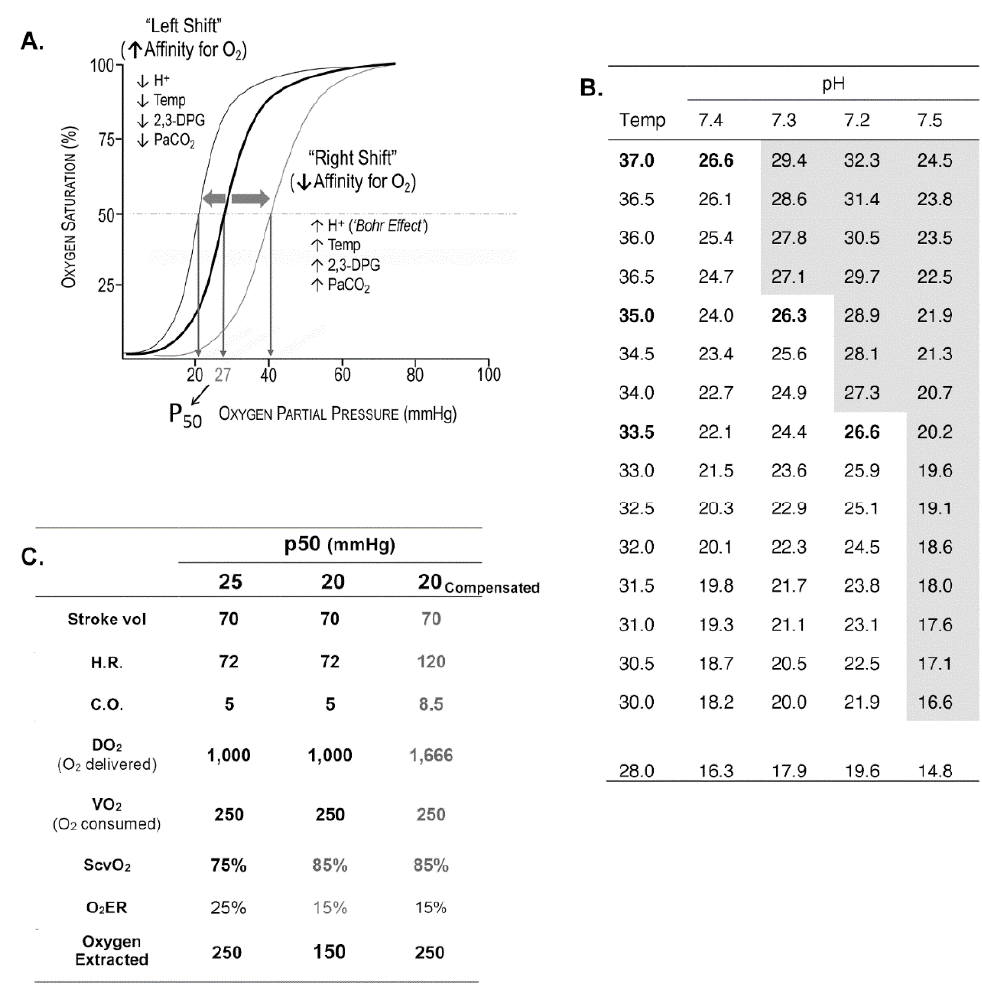
Figure 1. ( A ) OHD curve which relates the saturation of Hgb ( y -axis) to the degree of partial pressure of oxygen to which Hgb is exposed ( x -axis). The pO 2 that saturates ½ of Hgb is referred to as p50, which in this example p50 = 27 mmHg. The p50 is the conventional measure of affinity of Hgb for oxygen. The lower the p50 the higher the affinity of Hgb for oxygen. The ‘steep’ portion of the oxyHgb dissociation curve is in the range of pO 2 that exists in systemic capillaries (thus a small decrease in systemic capillary pO 2 can result in the release of large amounts of oxygen for diffusion to, and uptake by cells). As shown in the figure, several factors increase the affinity of Hgb for oxygen (leftward shift; ↓ p50) or decrease affinity (rightward shift; ↑ p50). Biochemically, H+ is a heterotropic allosteric inhibitor of Hgb, whereas O 2 is a homeotropic allosteric activator of Hgb. ( B ) Hypothermia and acidosis have opposing effects on p50. Lower temperature shifts the curve to the left increasing Hgb affinity for oxygen and decreasing offloading in capillaries; low pH (increase in H+) decreases the affinity of Hgb for oxygen (Bohr effect) increasing oxygen availability to reverse anaerobic metabolism. A trauma patient may be, and often is hypothermic and acidotic (and coagulopathic). Whether there is a significant change in p50 can be calculated using the Hill–Langmuir equation. ( C ): Hypothetical oxygen transport variables of a normal subject (Temp = 37 °C; p50 = 25 mmHg) and a subject with hypothermia (Temp = 31 °C; p50 = 20 mmHg), before and after compensation. The p50 at 31 °C and pH = 7.4 is calculated using the Hill–Langmuir equation. A venous blood gas is obtained through a Swan Catheter introducer (7.5Fr) with the tip in the superior vena cava reveals in the hypothermic subject, central venous oxygen saturation (ScvO 2 ) = 85%. This reflects the fact that hypothermia increases the affinity of Hgb for oxygen, shifting the Hgb dissociation curve to the left. A ScvO 2 of 85% would imply only 15% of the delivered 1000 mL of oxygen (DO 2 ) prior to com- pensation is being offloaded, which is approximately 150 mL/min, well below VO 2 (250 mL/min). The hypothermic patient can compensate by increasing cardiac output and hence DO 2 . Assume that stroke volume is unchanged (although a well-known consequence of tachycardia is a reduction in stroke volume), and cardiac output increases by an increase in heart rate (HR) from 72 beats/min to 120 beats/min (a 40% increase in HR causing a substantial increase in myocardial oxygen demand).